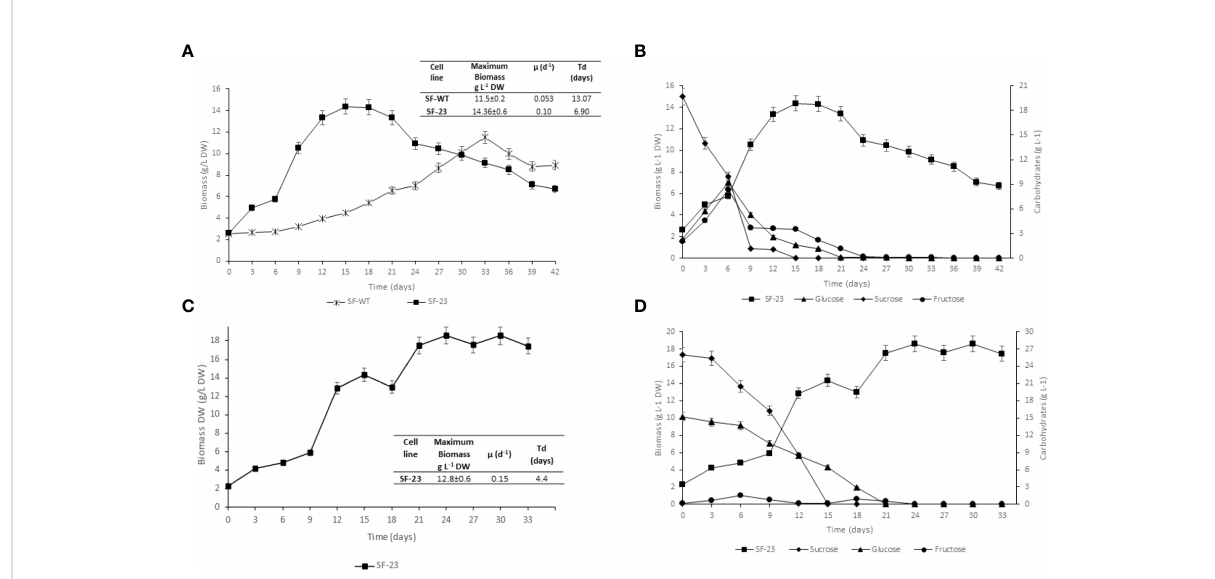
FIGURE 4 Characterization of C. papaya suspension cell lines. (A) Biomass growth of C. papaya SF-WT and SF-23 cell lines in Erlenmeyer shake fl asks (100 ml). Kinetic parameters of C. papaya cell suspension batch cultures in fl asks (100 ml) are summarized in the Table. Growth rates in the SF- WT and SF-23 cell lines were statistically different according to Tukey ’ s test ( P < 0.05). (B) Carbohydrate consumption (sucrose, glucose, and fructose) of C. papaya SF-23 cell line in Erlenmeyer shake fl asks (100 ml). (C) Biomass growth of C. papaya SF-23 cell line during culturing in airlift bioreactor. Kinetic parameters C. papaya SF-23 suspension cell line in airlift bioreactor are shown in the Table. (D) Carbohydrate consumption (sucrose, glucose, and fructose) for C. papaya SF-23 cell line in airlift bioreactor. Data are reported as mean ± SD of one experiment with three